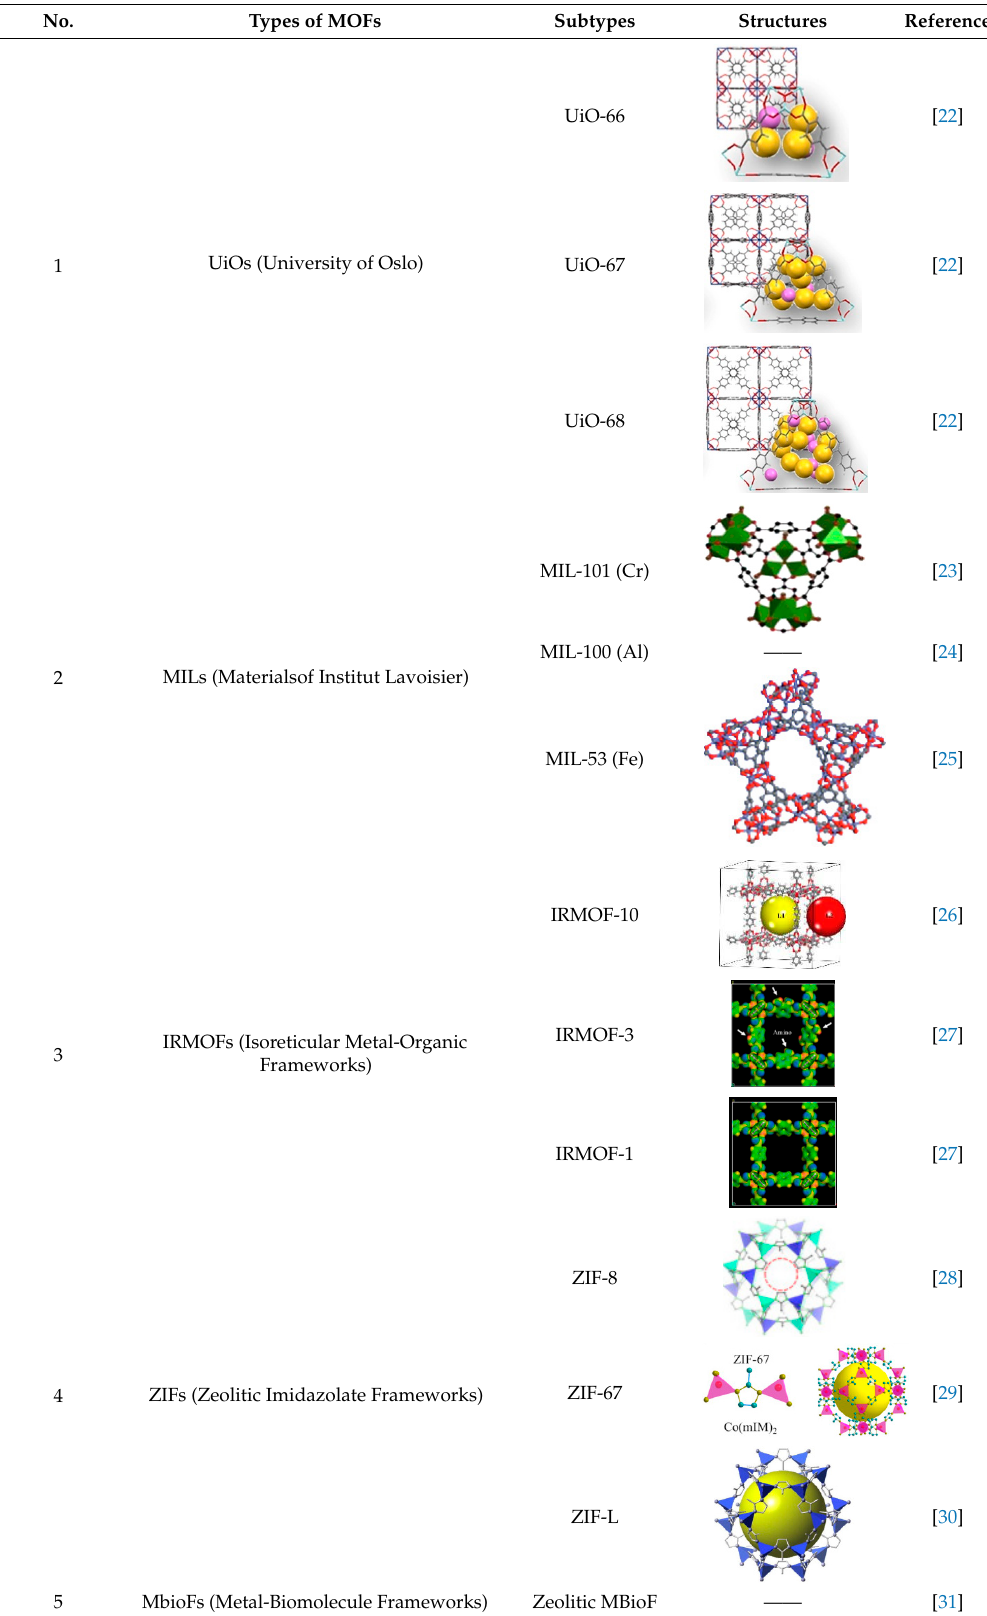
Table 1. The shapes of metal organic frameworks found in previous research studies. No.